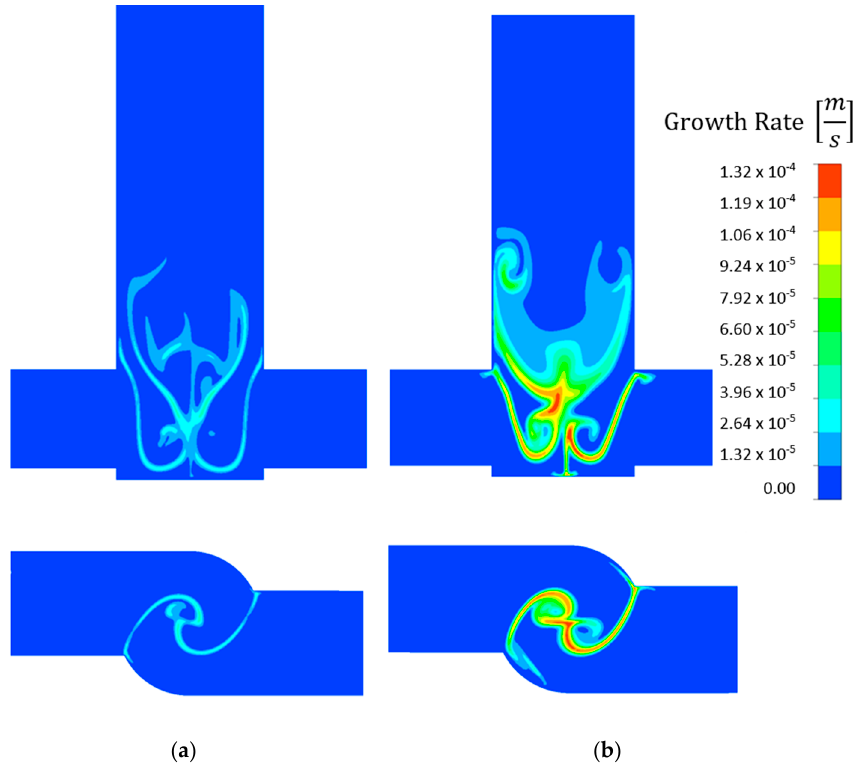
Figure 11. Comparison of growth rate [m s − 1 ] contour plots for 0.6 mol/dm 3 AS and ( a ) 20 and ( b ) 50 mL/min flow rates in a V-type reactor.